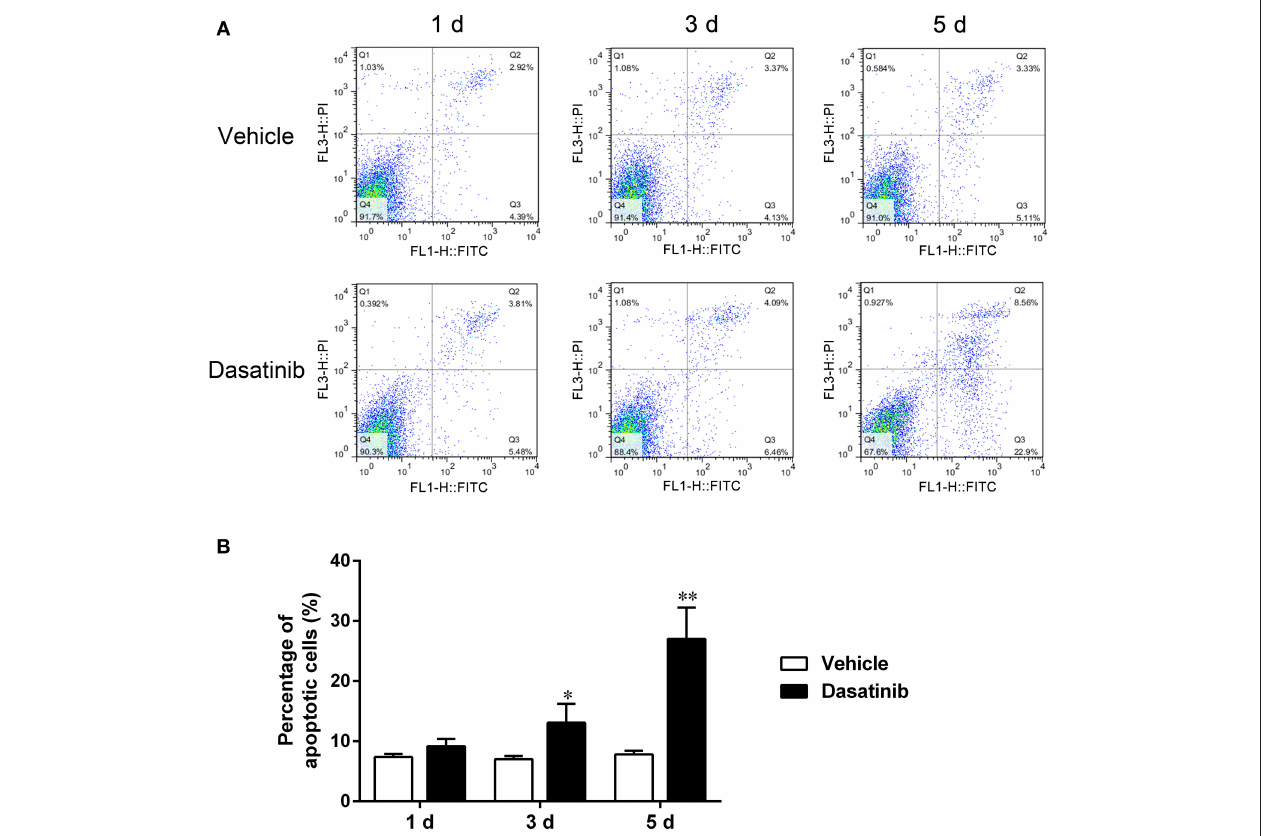
FIGURE 7 | Flow cytometry was used to evaluate FLS apoptosis. (A) The percentages of early and late apoptosis cells treated with dasatinib and control vehicle for 0, 1, 3, and 5 d. (B) Quantitative analysis of the total percentage of apoptosis (including early and late apoptosis). * P < 0.05, ** P < 0.01 vs. vehicle group ( n = 3 per